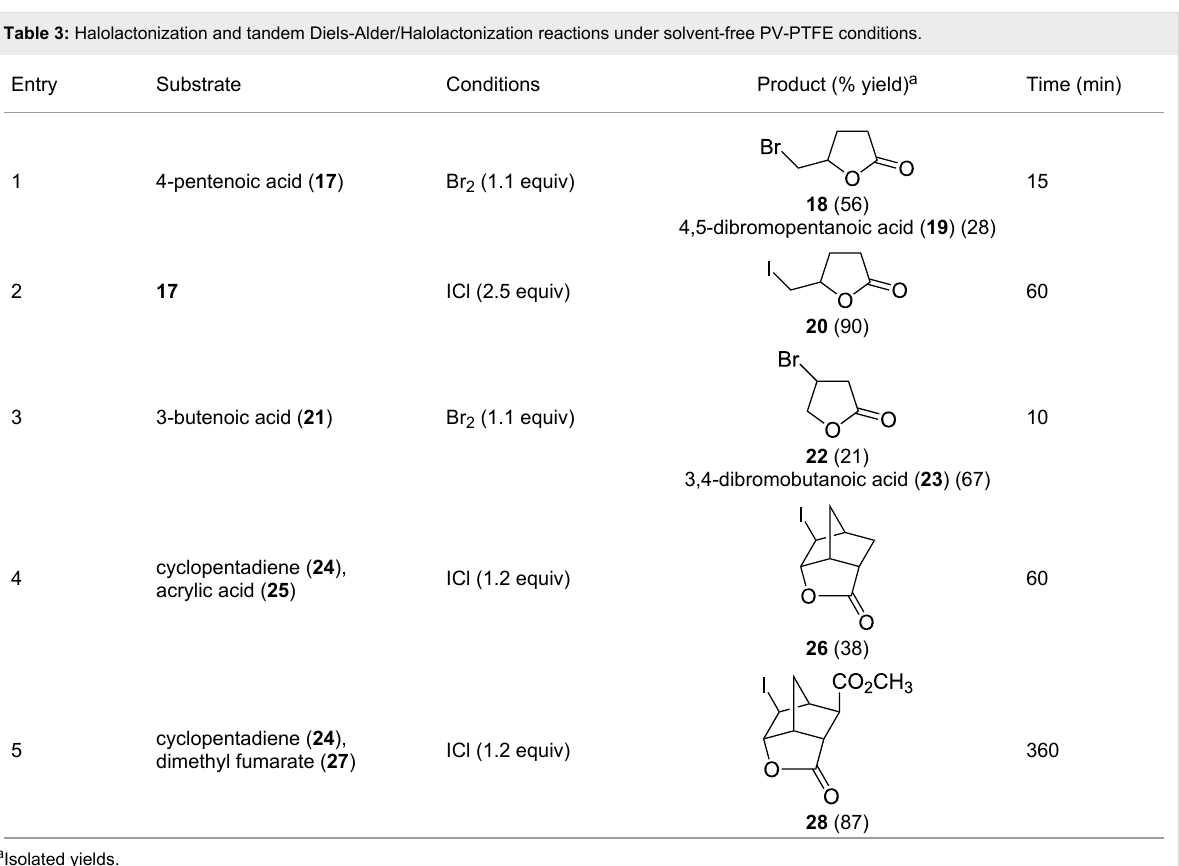
Table 3: Halolactonization and tandem Diels-Alder/Halolactonization reactions under solvent-free PV-PTFE conditions.